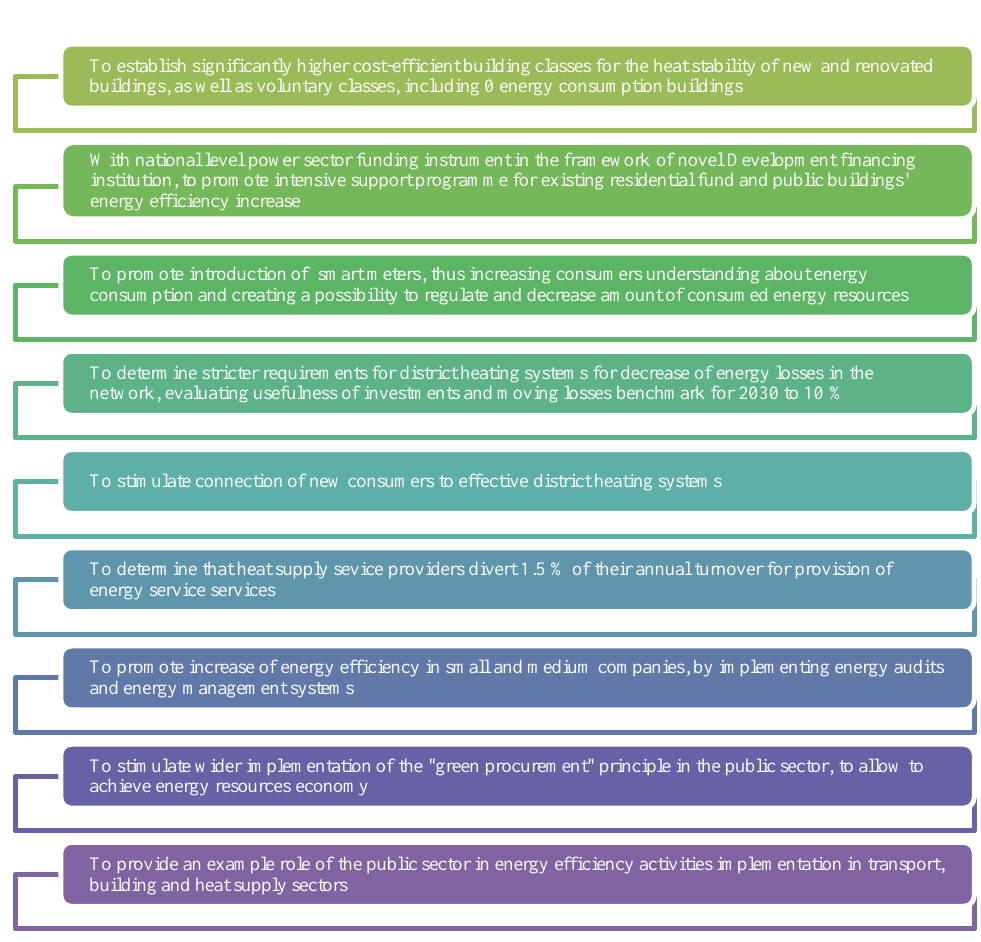
Fig. 7. Energy efficiency increase